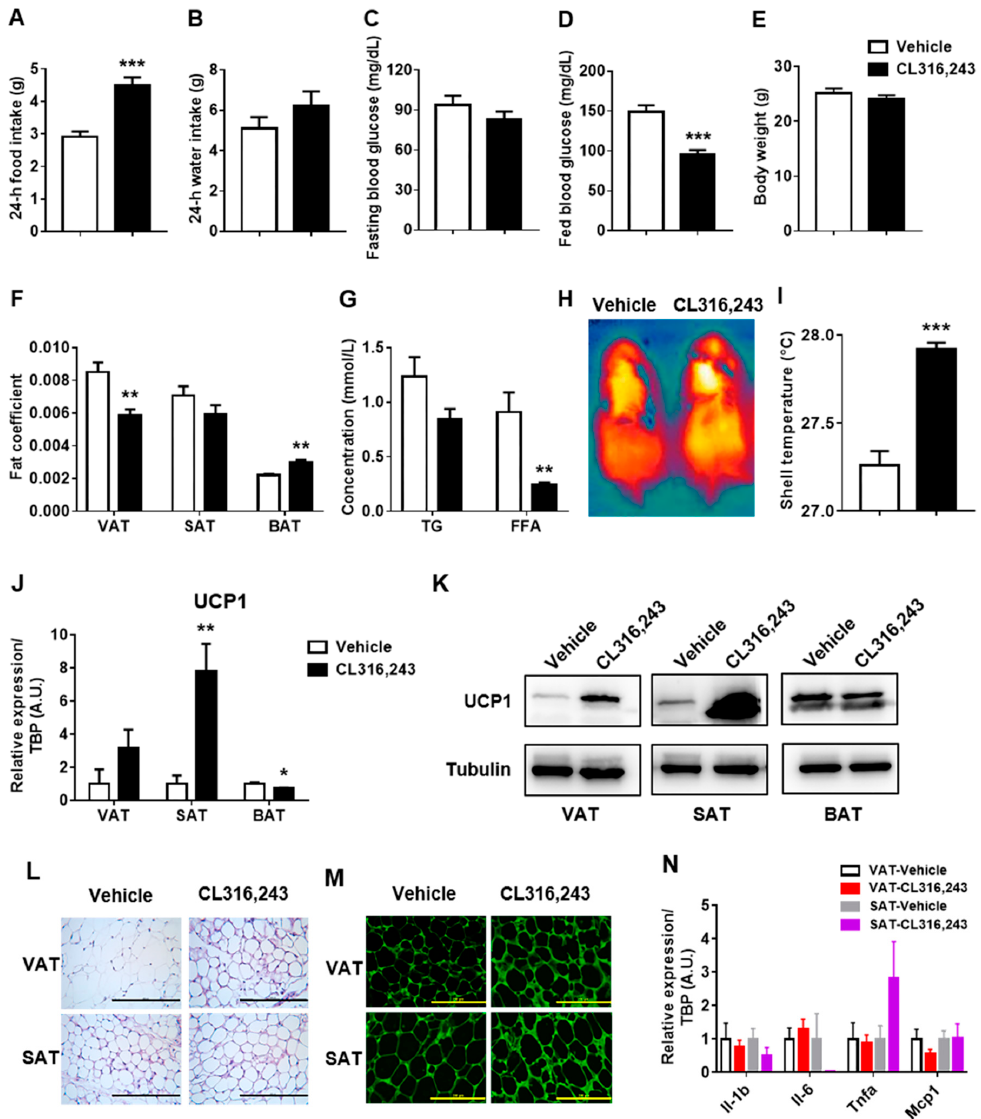
Figure 2. Adrenergic stimulation-induced browning heterogeneity of white adipose tissue and ameliorated systemic metabolism. C57BL/6J mice were injected intraperitoneally with CL316,243 at the dose of 1 mg/kg/d for 10 days and the general parameters were measured ( n = 5). ( A ) 24-h food intake; ( B ) 24-h water intake; ( C ) Fasting blood glucose; ( D ) Fed blood glucose; ( E ) Body weight; ( F ) Fat coefficient of visceral adipose tissue (VAT), subcutaneous adipose tissue (SAT), and brown adipose tissue (BAT) in vehicle and CL316,243-injected mice; ( G ) The concentration of blood triglyceride (TG) and free fatty acids (FFA); ( H ) The shell temperature was spotted by a thermal imaging camera purchased from FLIR when mice were under anesthesia and ( I ) the temperature was analyzed using FLIR tools. All data are presented as mean ± SEM. ** P < 0.01; *** P < 0.001 compared with Vehicle group; ( J ) qPCR and ( K ) immunoblotting analysis of UCP1 expression in VAT, SAT, and BAT of mice injected with CL316,243. qPCR data are normalized to TATA box-binding protein (TBP) and presented as mean ± SEM, n = 5. * P < 0.05; ** P < 0.01 compared with Vehicle group; ( L ) H&E staining and ( M ) immunohistochemistry staining of UCP1 in VAT and SAT of mice injected with CL316,243. Scale bar = 200 µ m. ( N ) qPCR analysis of interleukin-1 beta (Il-1b), interleukin-6 (Il-6), tumor necrosis factor alpha (Tnfa), and monocyte chemoattractant protein 1 (Mcp1) in VAT and SAT of mice injected with CL316,243. qPCR data are normalized to TBP and presented as mean ± SEM, n =